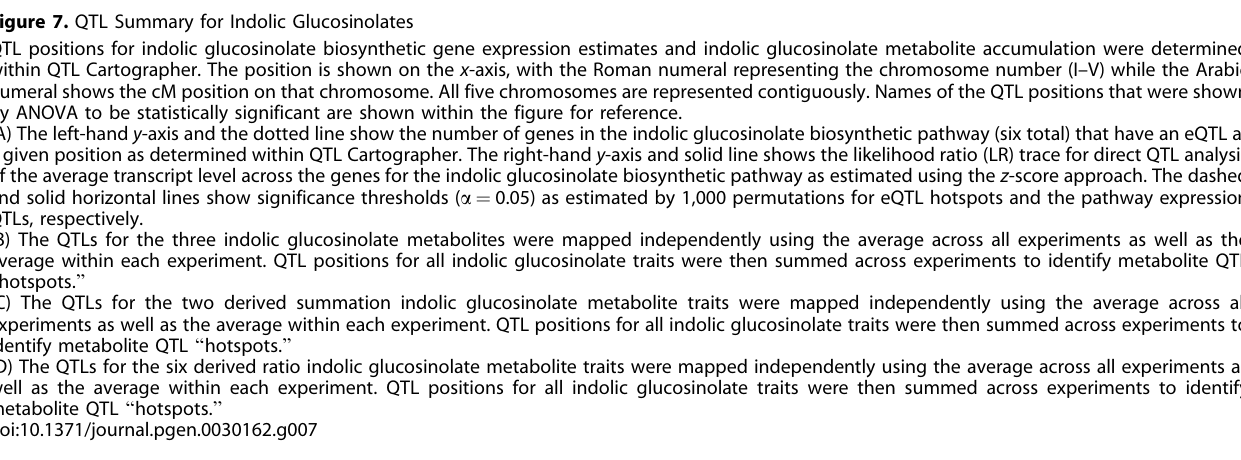
that for both pathways, all eQTLs collocate with metabolite QTLs (Table 2, Figures 2 and 7). This suggests that expression